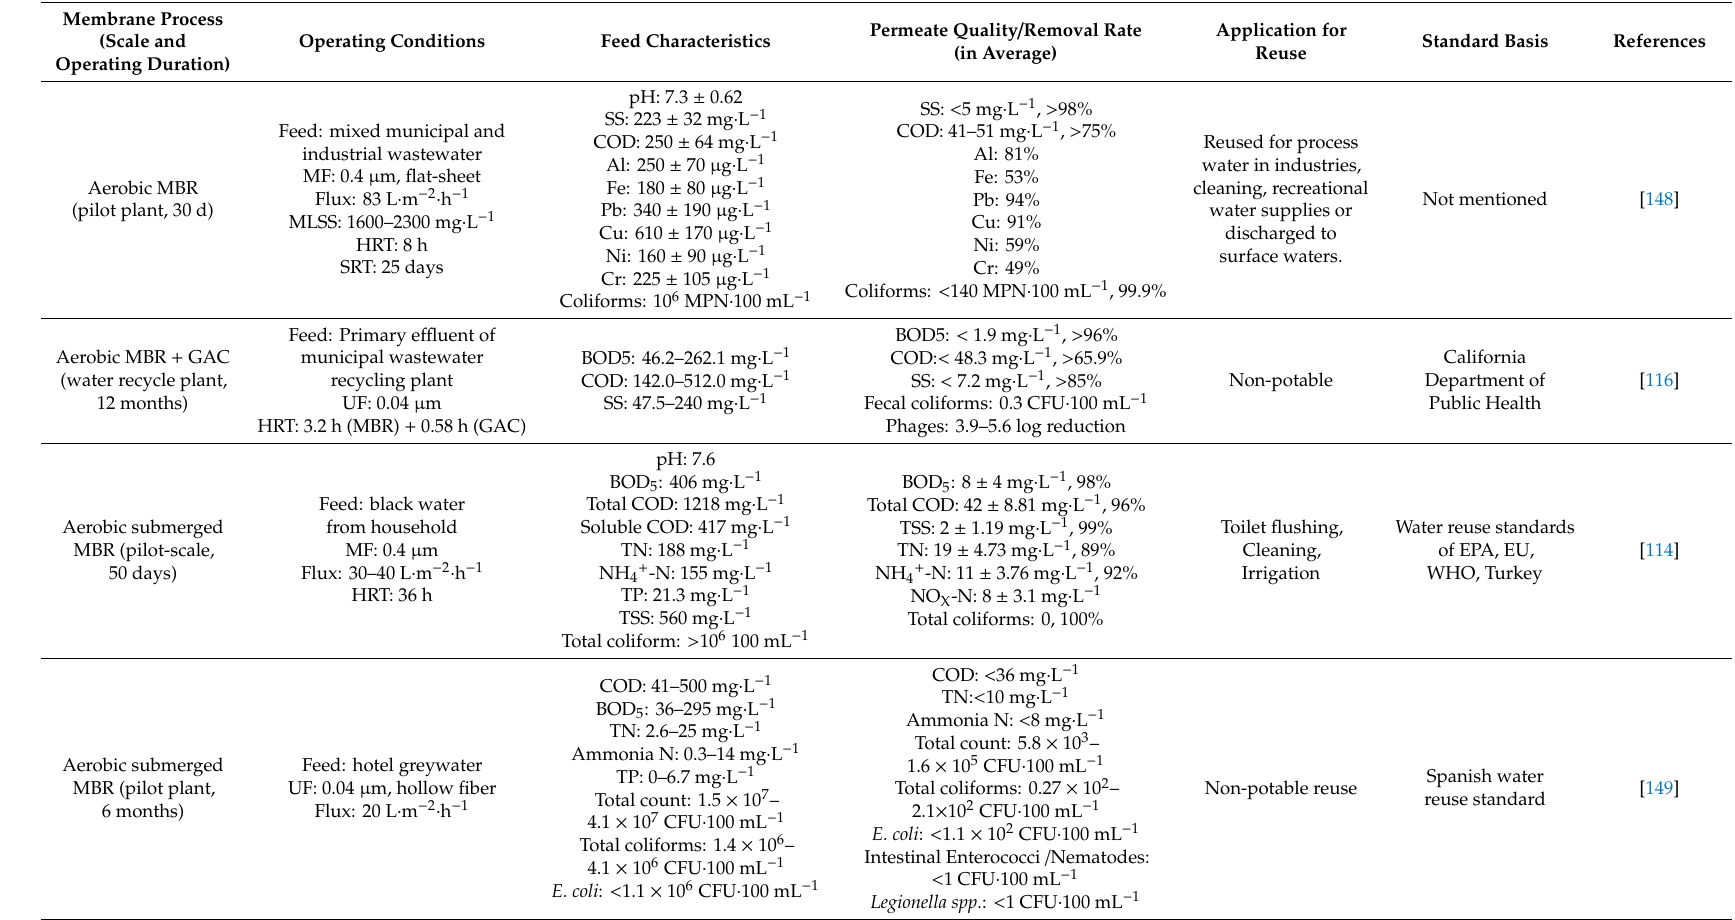
Table 8. Membrane bioreactors (MBR) for water reuse